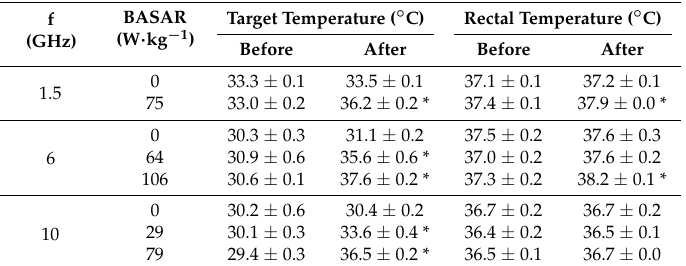
Table 4. Temperature conditions in the experiment.